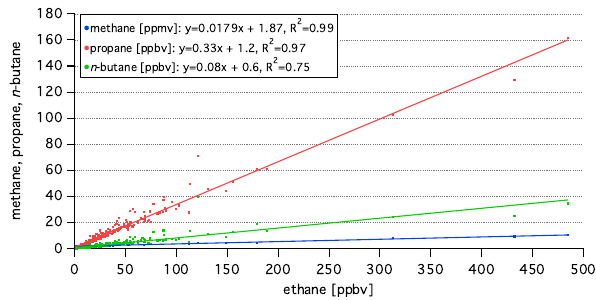
Figure 8. Correlation of methane, propane and n -butane with ethane for locations within and around the Pinedale Anticline dur- ing 2010–2013 surveys.